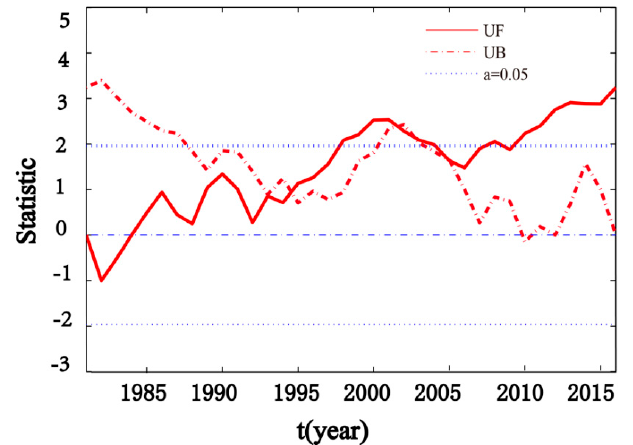
Figure 4. The Mann – Kenda (M-K) test for summer extreme precipitation over the Tibetan